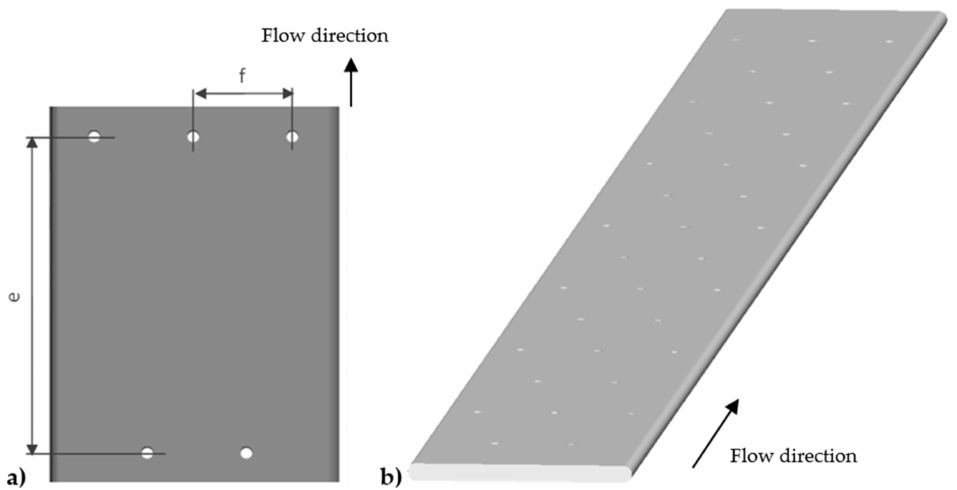
Figure 7. Flat tube with cylindrical pins. ( a ): Detailed geometry of passive inserts. Pin diameter